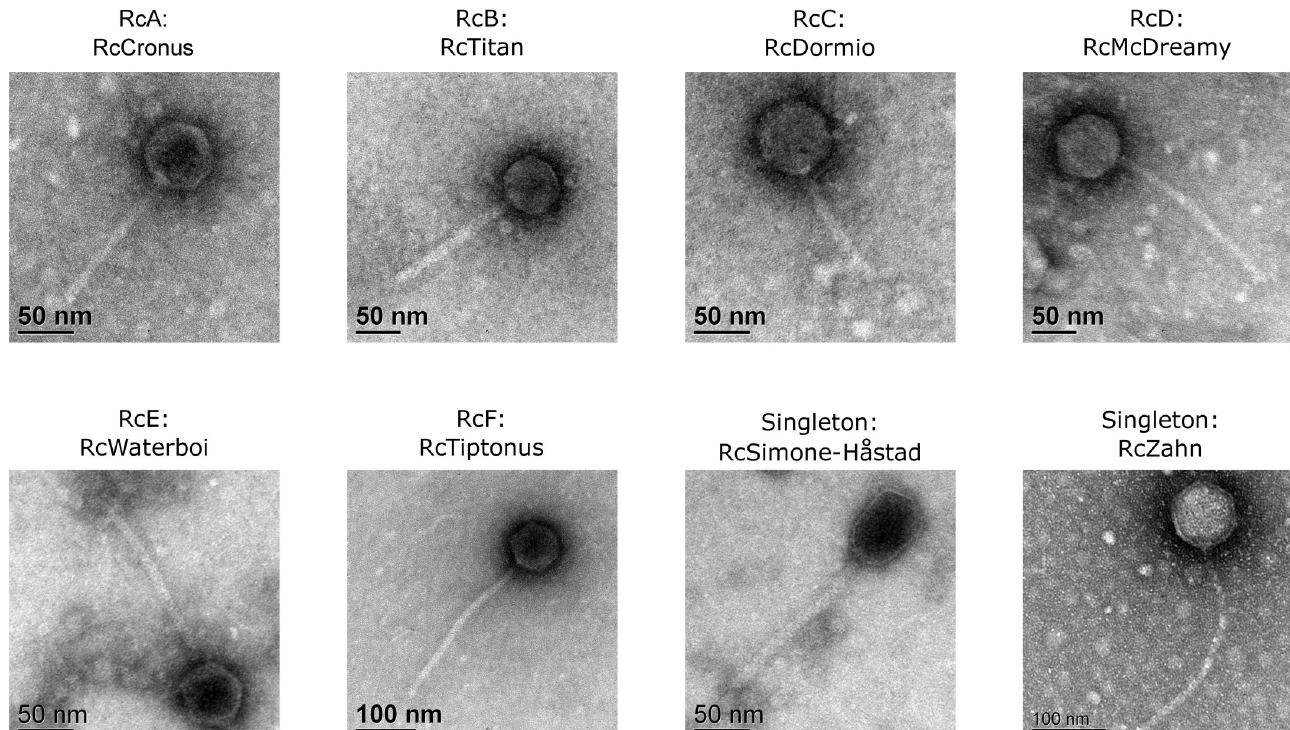
Fig 1. R . capsulatus phage virion morphologies. Representative transmission electron micrographs of virion particles from each R . capsulatus phage cluster shows the presence of Siphoviridae morphologies. Cluster designations, RcA-RcF or Singleton, are indicated above the representative phage name.